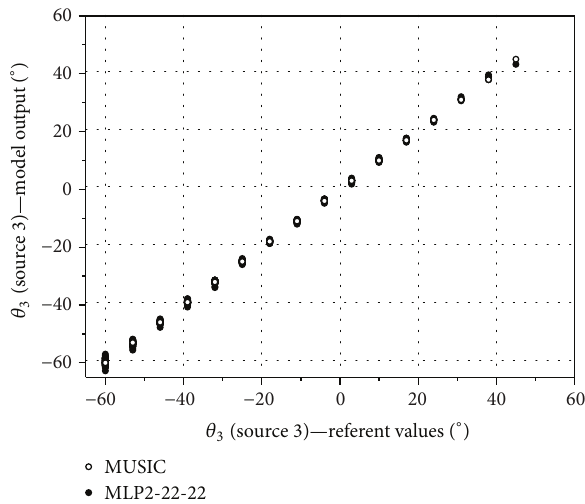
Figure 8: Scattering diagram of chosen MLP-DoA 3 network (MLP2-22-22) and MUSIC model for output 1 (source 1) obtained by simulation on the test set(Case 𝑠 = 3 ).